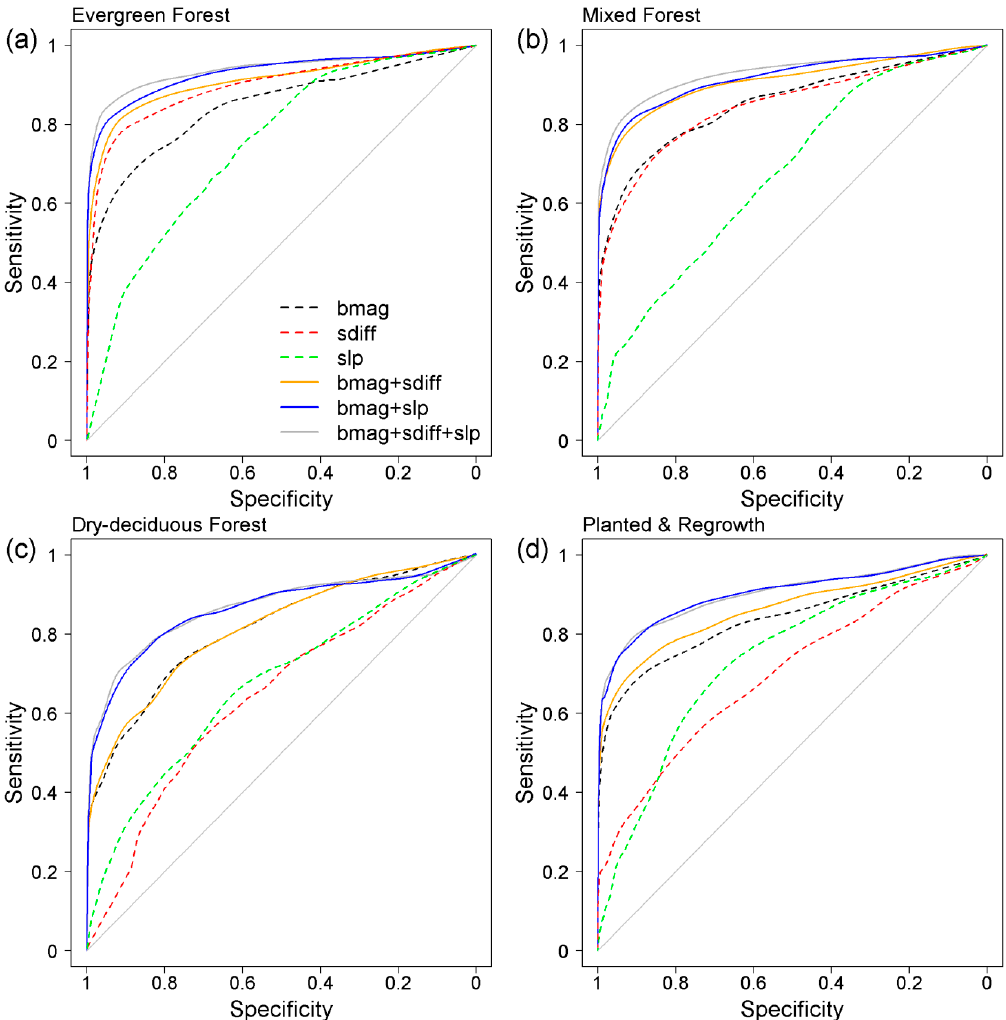
Figure C1. Receiver operating characteristic (ROC) curves for models using different explanatory variables and combinations of variables derived from NDVI time series. Panels represent forest type: evergreen forest ( a ); mixed forest ( b ); dry-deciduous forest ( c ); and planted forest and regrowth ( d ). Table C1. Area under curve (AUC) estimates for regression models using NDVI and different combinations of parameters, by forest type. AUCs for each model are derived using receiver operating characteristic (ROC) curves presented in Figure C1.